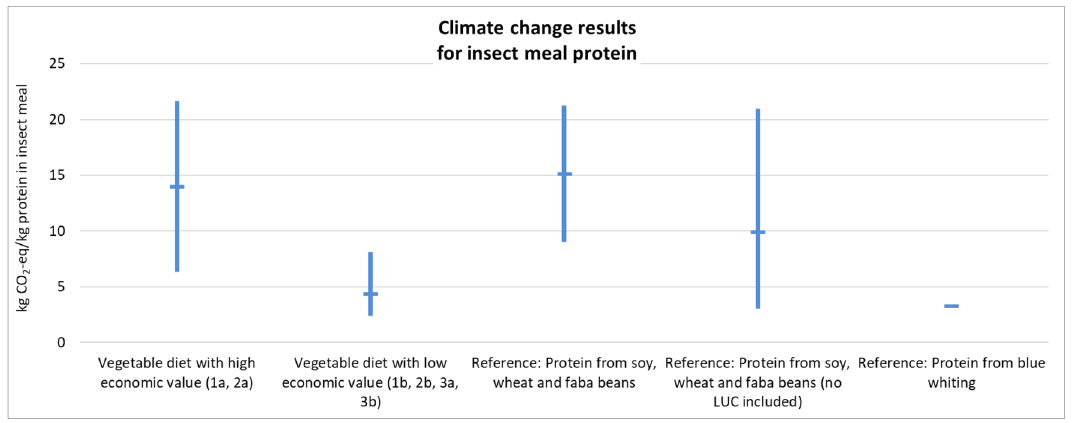
Fig. 7 Climate change results for insect meal, presented for two groups based on insect diet (results given per kg protein delivered to the west coast of Norway) compared with reference products (per kg delivered to feed mill in Norway). Number of insect cases: 6 in